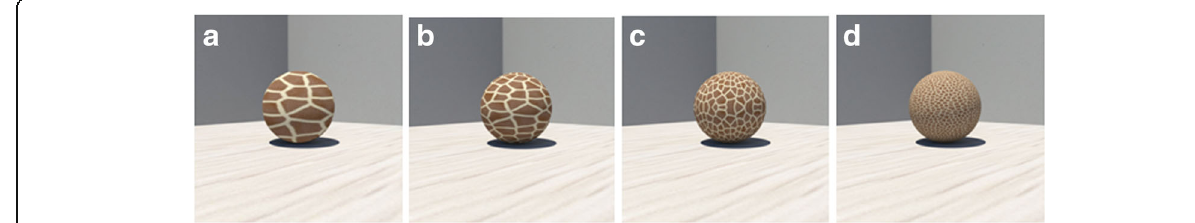
Fig. 2 Left view of four original stereoscopic images with different textural density: a , b , c and d represents different textural density rank, respectively. From a to d , the texture density of "ball" increases gradually